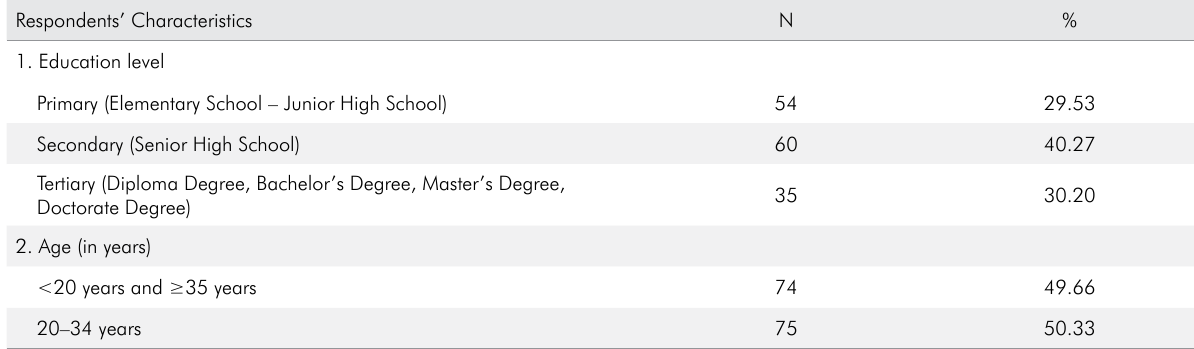
Table 2. Respondents’ Characteristics Respondents’